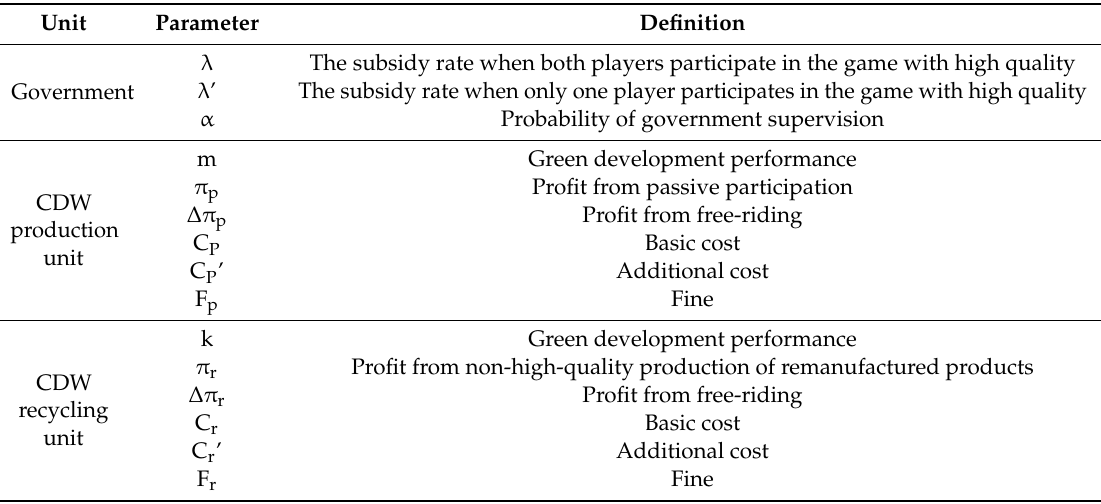
Table 1. Definition of